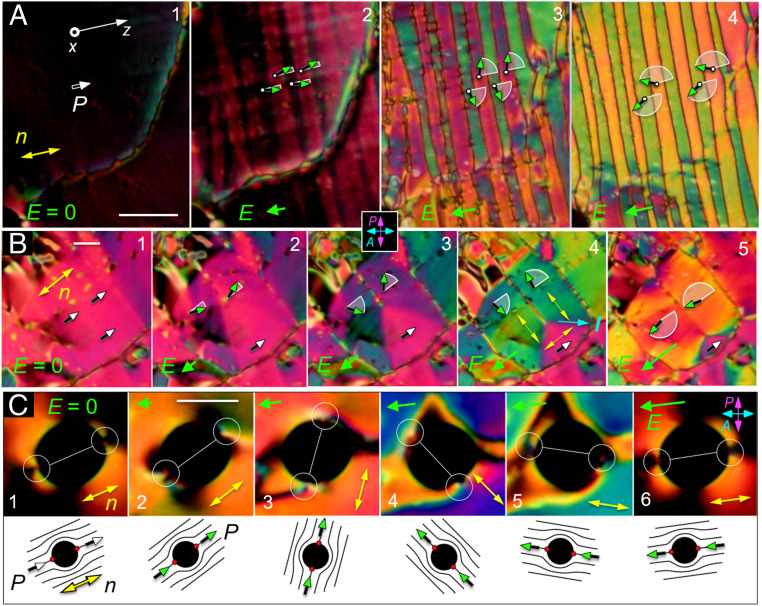
Common polarization reversal scenarios in RM734. Field-induced reorientation of P is indicated schematically using white arcs and green vectors. (A) Stripe formation. Applying a 5-Hz triangle-wave electric field with peak amplitudes in the range 0 < Ep < 10 V/cm to a region with an initially uniform in-plane director (panel 1) induces a periodic modulation in the orientation of n(r) and P(r) along z (a director bend wave; panel 2) whenever the field changes sign. As the applied field strength is increased (panels 3 and 4), the stripes form with sharper boundaries and have uniform internal orientation determined by the field strength. The zigzag arrangement of the director in successive stripes ensures that the normal component of P is constant across the stripe boundaries, so that there is no net polarization charge there. (B) Polygonal domains. During field reversal, polarization charge effects alternatively lead to the formation of tile-like domains with uniform n(r). These polygons have sharp domain boundaries that are oriented such that P⋅l, where l is along the boundary, is the same on both sides of the boundary, reducing space charge. The angular jump in n(r) across the boundary highlighted in panel 4 is 90°. (C) Director field reorientation around inclusions. Air bubbles in the cell can be used to track the orientation of n(r) in a reversing field. The director field near the bubble, sketched below each panel, is locally distorted, bending around the inclusion with splay deformations confined to two 180° wedge disclinations (red dots) located at opposite ends of the bubble. The blue color in panels 4 and 5 is indicative of a TU state of the kind shown in Fig. 4, with a surface disclination then moving out from the bubble boundary to give the final, uniform state seen in panel 6. (Scale bars, 40 µm in A, 30 µm in B, and 20 µm in C.)